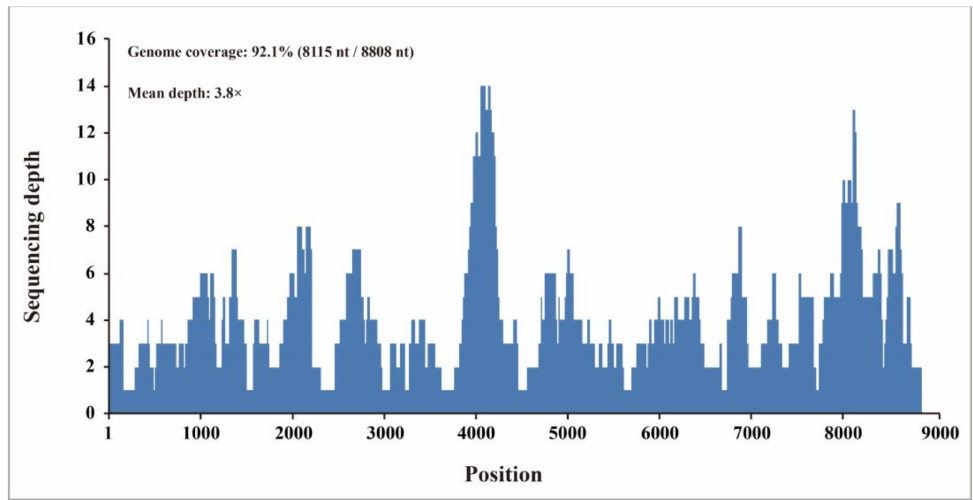
Figure 1. Mapped read count plot of the Hepacivirus N isolate GDZJ02 genome. The histograms show the coverage depth per base of the Hepacivirus N isolate GDZJ02 genome. The mean sequencing depth of the Hepacivirus N isolate GDZJ02 genome was 3.8 ×